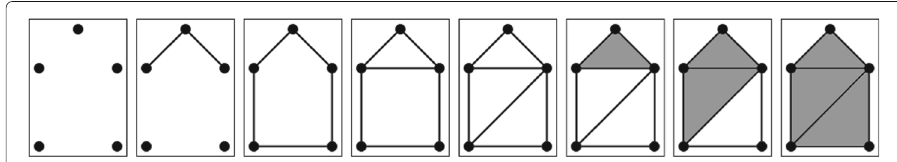
Fig. 5 A filtration for δ = 0,1,2,3,4,5,6,7 (from left to